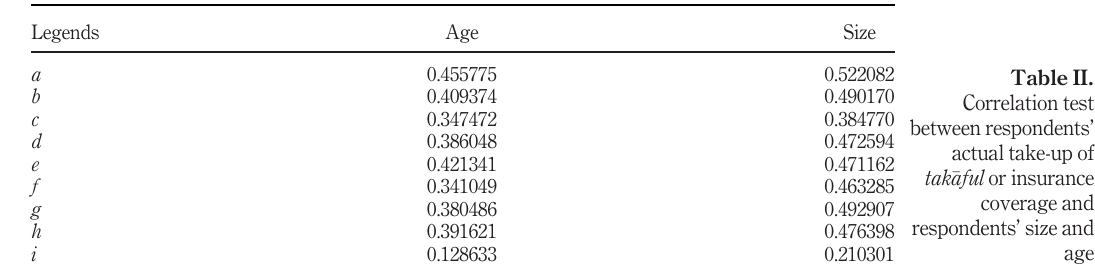
Figure 13. Probability plot of respondents ’ subscriptions to tak (cid:1) aful or